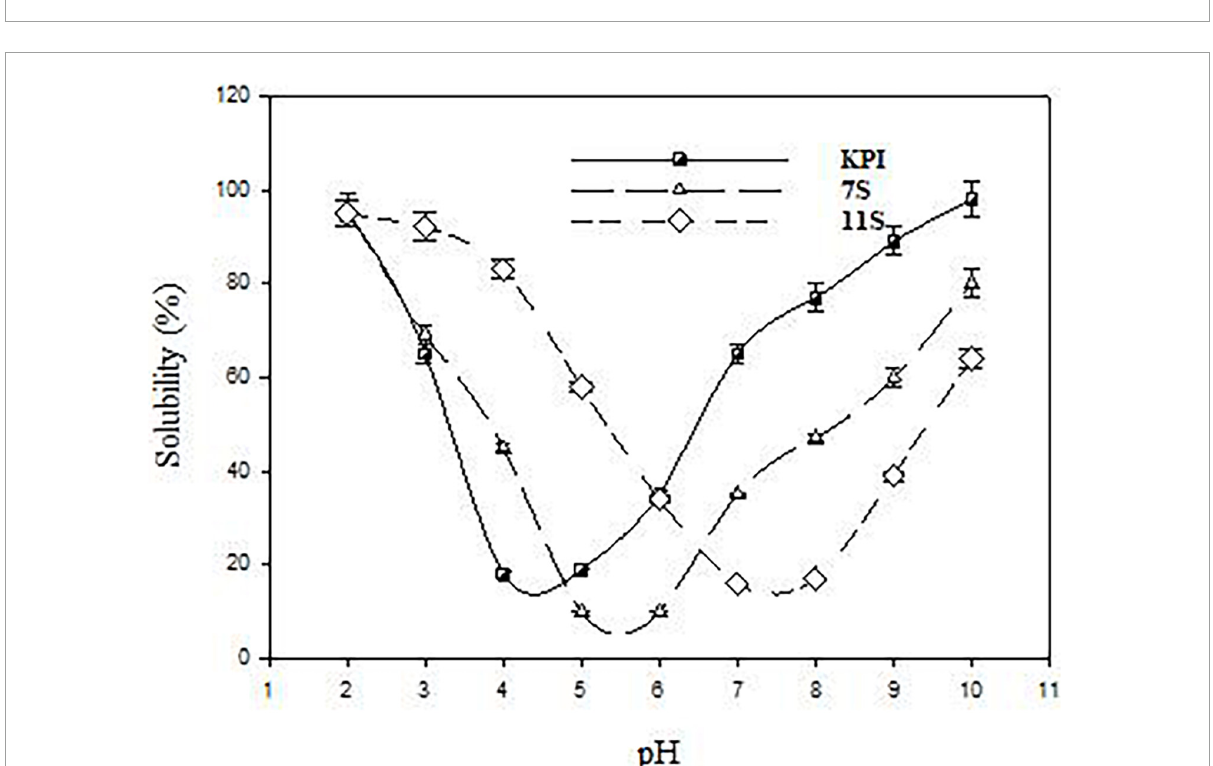
FIGURE5 pH solubility profile of red kidney bean protein isolate (KPI), 7S globulin (7S), and 11S globulin (11S).